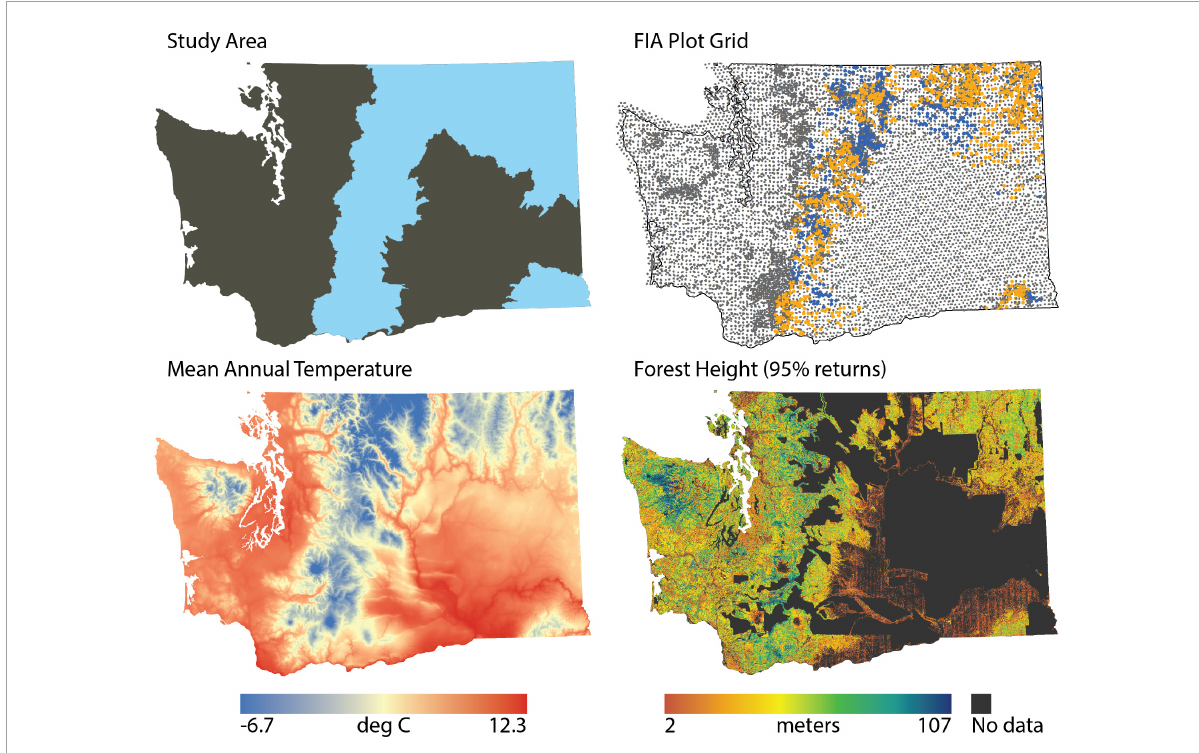
FIGURE1 Study area map, highlighting the study area (blue), the distribution of FIA plots (gray = not in this study, orange = this study with DAP, blue = this study without DAP), mean annual temperature (blue = cooler, red = warmer) (Wang et al., 2016), and DAP vegetation height (orange = shorter, blue =